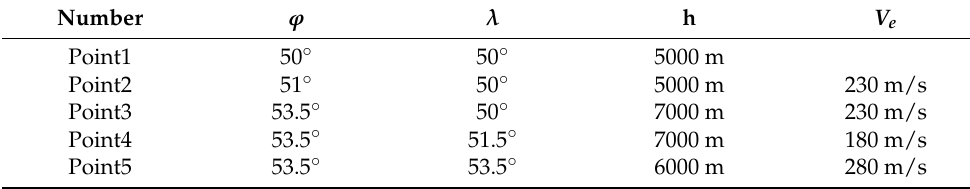
Table 2. Waypoint settings for Section